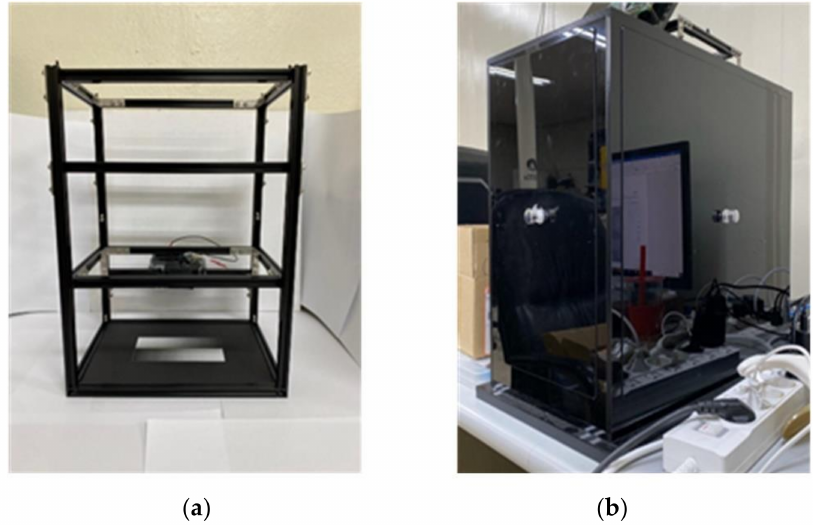
Figure 3. Gel-document emulation system: ( a ) emulator; ( b ) dark